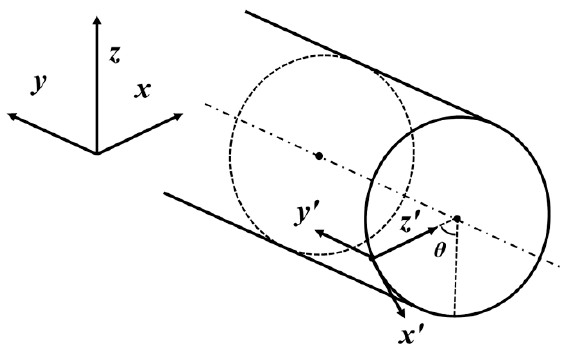
Figure A2. Schematic of local coordinate system for contact calculation.